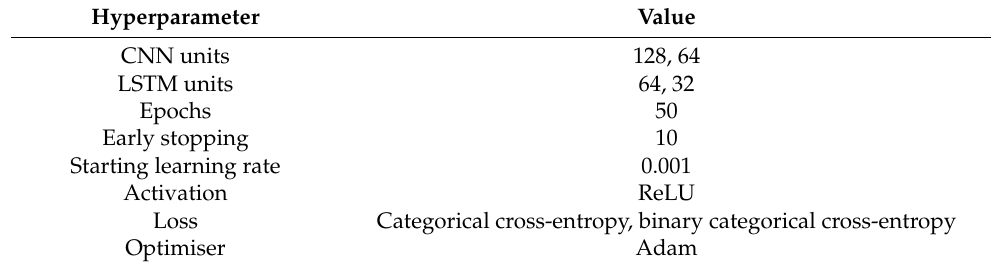
Table 7. Hyperparameters of the model and their